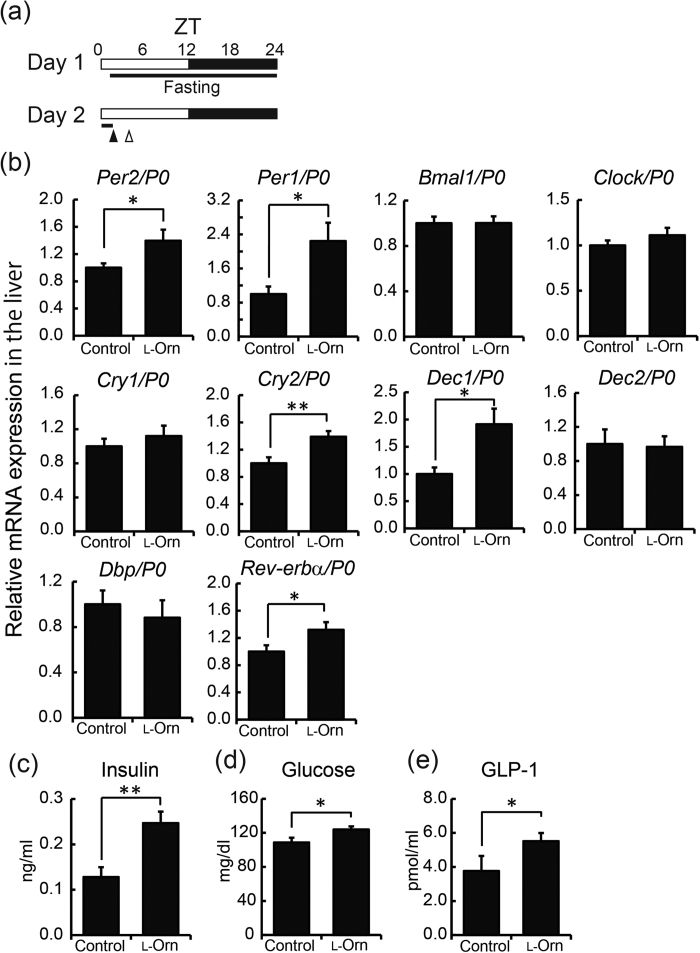
Effects of L-ornithine administration at ZT 1 on secretion of insulin, GLP-1, and glucose in plasma, and clock genes in the liver.(a) Experimental schedule. Open and filled bars indicate light and dark periods, respectively. Mice were entrained to the light-dark cycle for at least 14 days. At ZT 1, l-ornithine (1,000 mg/kg) or vehicle was administered to mice after 24 h fasting by oral injection (filled arrowhead); at ZT 2, plasma and tissues were collected (open arrowhead). (b) RT-PCR analysis of clock genes in the liver. mRNA expression was normalized to P0. (c–e) Insulin, glucose and total length GLP-1 concentration in plasma (mean ± SEM, n = 10 mice respectively). **P < 0.01, *P < 0.05 versus control (Mann-Whitney U test).